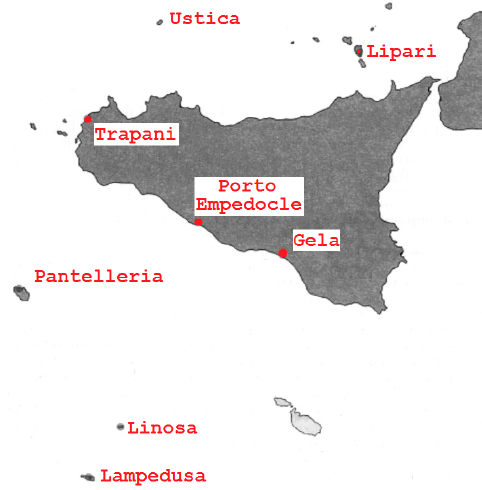
Figure 8. Distribution of desalination plants in Sicily.